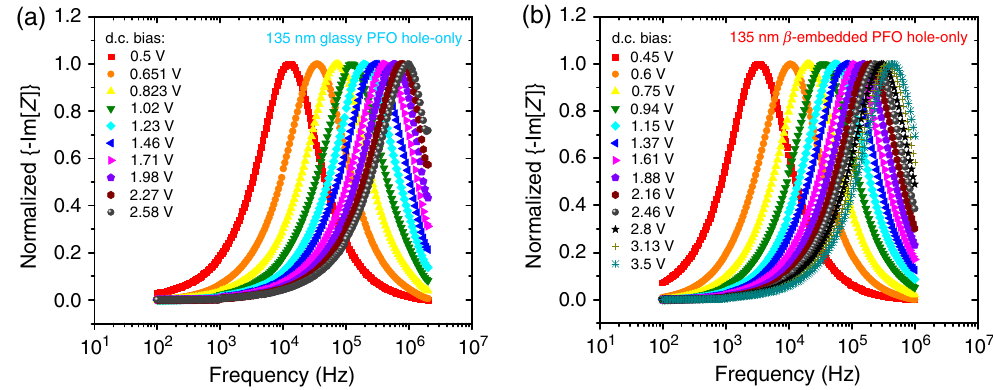
FIG. 23. Normalized frequency-dependent − Im ½ Z (cid:4) spectra of 135-nm asymmetric HMW PFO hole-only devices in (a) glassy and (b) β -embedded states. At each given dc bias, we reciprocate the frequency peak of the − Im ½ Z (cid:4) spectrum to a dc hole transit time, from which a corresponding steady-state hole mobility can be calculated [as per Eq. (C1)]. The estimated μ correction for the built-in voltage V in order to finalize the evaluation of field-dependent steady-state μ bi